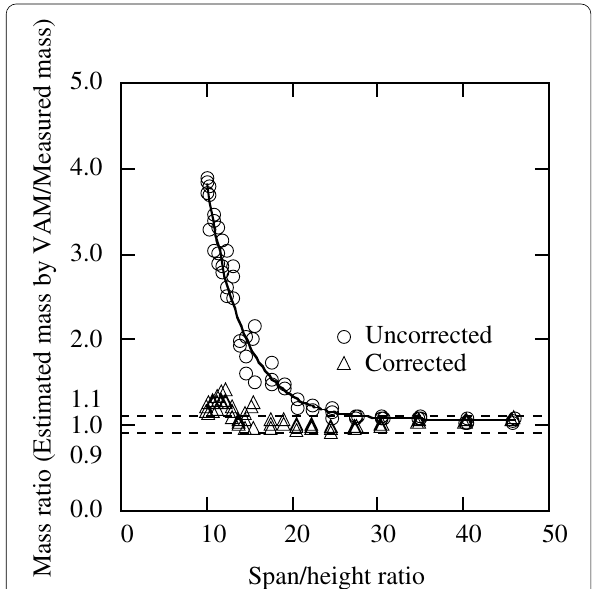
Fig. 9 Corrected mass ratio (estimated specimen mass by VAM/ measured specimen mass) at various span-to-height